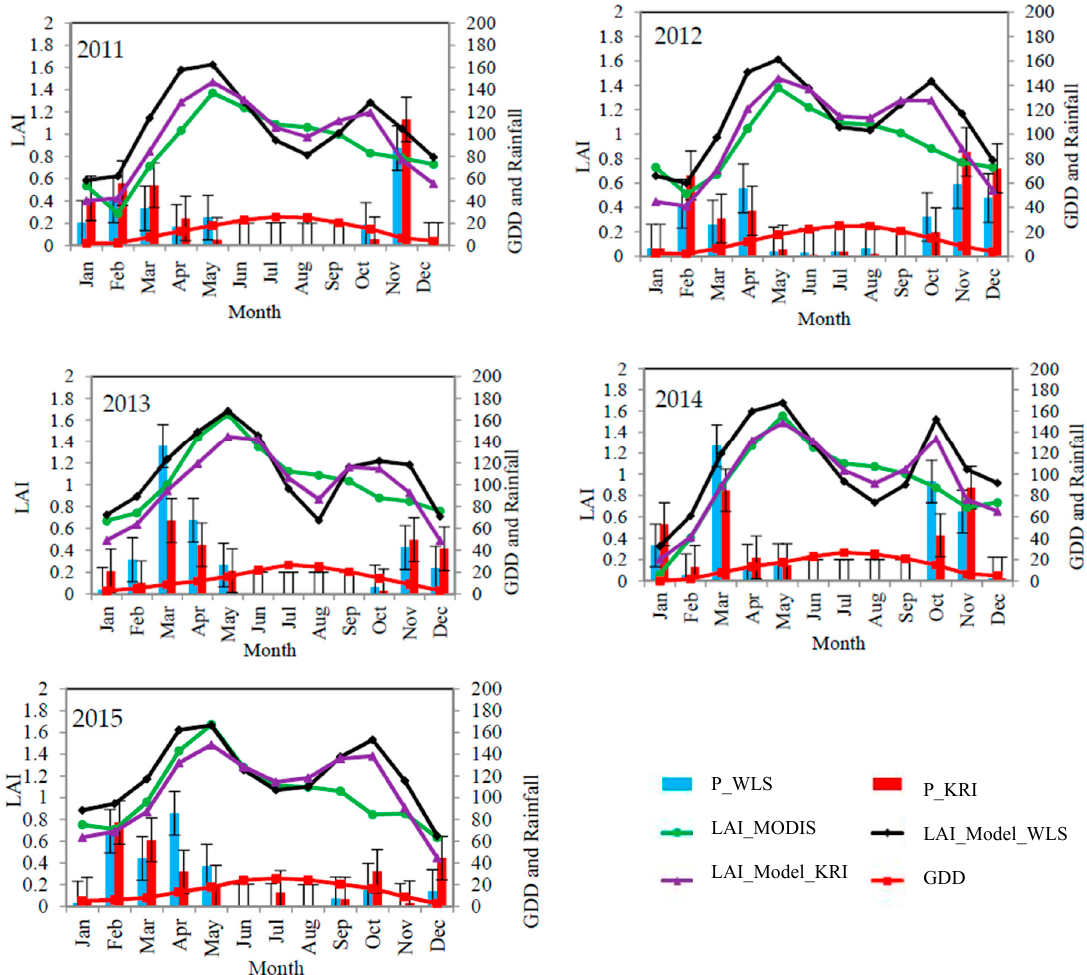
Figure 8. Monthly values for MODIS LAI, simulated LAI (using GDD and Kriging or WLS), rainfall (Kriging, WLS) and GDD for the years 2003 till 2015.